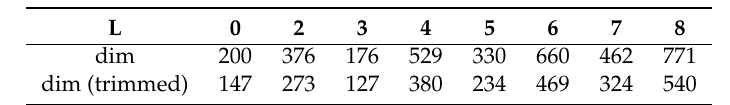
Table 1. Dimension of extended subbasis (second line) and trimmed subbasis (last line) for angular momentum used in the program (first